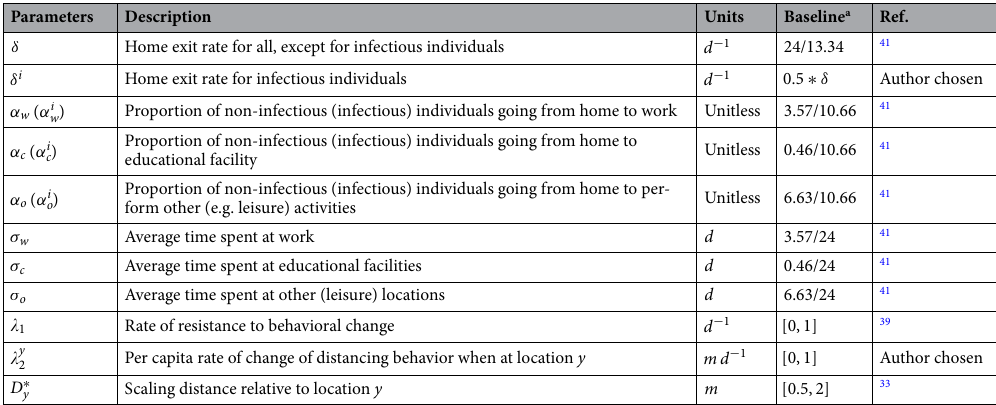
Table 2. Description of parameters and parameter values related to behavior. d: = day, m: = meters. a Average numerical value, the breakdown by blocks is listed in Table 4, found at the end of the “Numerical results” section.